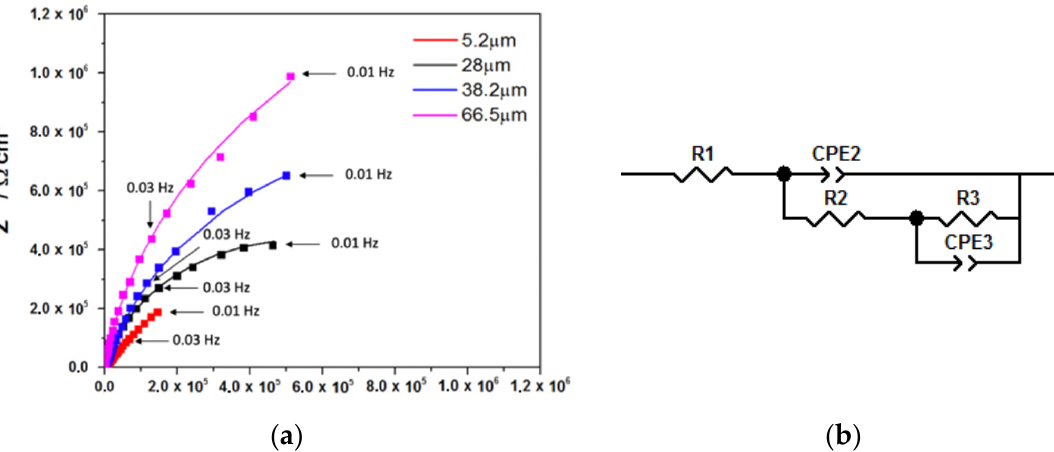
Figure 8. ( a ) Nyquist plots of samples collected after passivation with potentiostatic polarisation at 0.4 V for 6 h in 0.1 M NaOH solution ( b ) Equivalent electrical circuit (EEC) used to interpret the EIS data for all samples. Solid lines represent the fitted data.